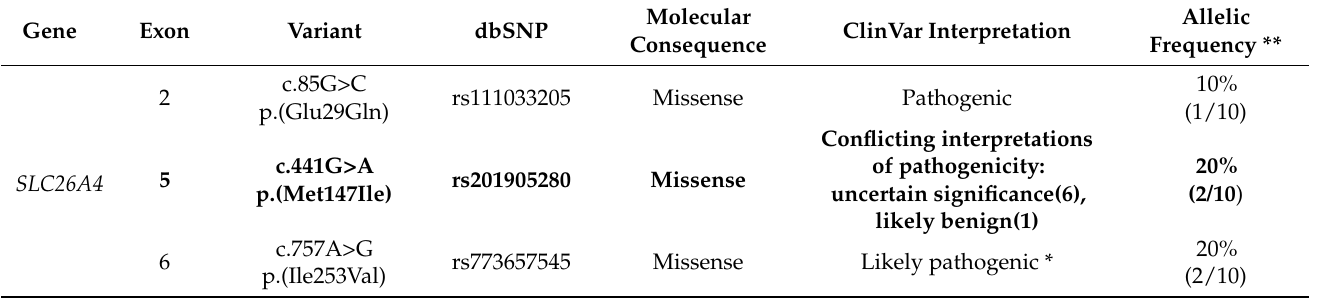
Table 1. Allelic frequency and clinical significance of the SLC26A4 , FOXI1 , and KCNJ10 gene variants identified in patients with IP-1, IP-2, IP-2+EVA, and isolated